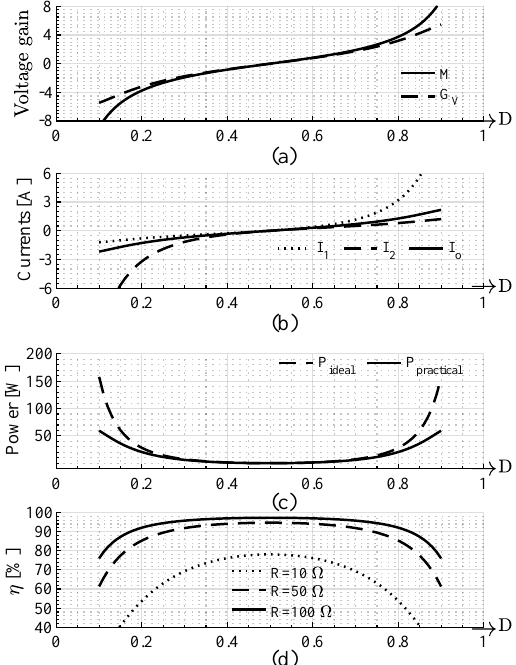
Figure 6. The characteristic plots obtained from the steady-state equivalent model as the duty cycle is varied: ( a ) Voltage gain with and without parasitic losses included, ( b ) individual converter and inverter currents, ( c ) inverter power considering the conduction losses only, and ( d ) efficiency considering the conduction losses only for three different load values as the duty cycle is